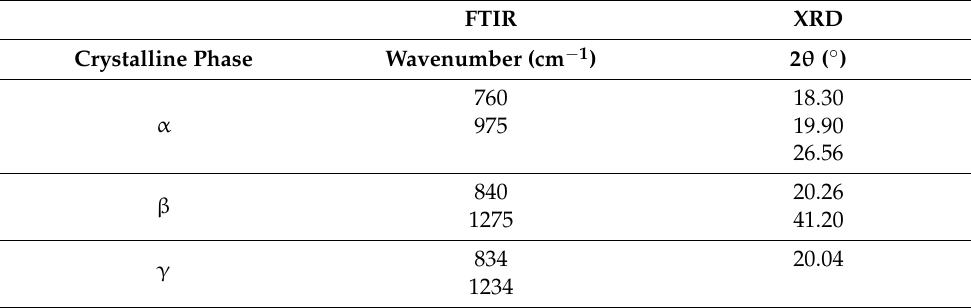
Table 2. Characteristic IR and XRD peaks of α -, β - and γ -PVDF crystalline phases. FTIR XRD Crystalline Phase Wavenumber (cm − 1 ) 2 θ ( ◦ ) α